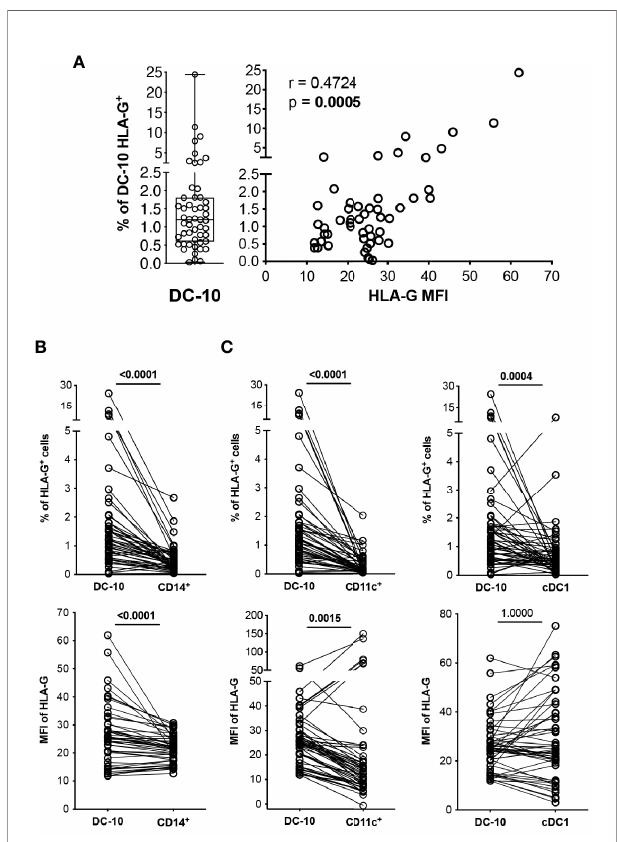
FIGURE 2 | DC-10 contain a high proportion of HLA-G-expressing cells. DC-10 (CD11c + CD14 + CD16 + CD141 + CD163 + ), CD14 + , CD11c + , and cDC1 (CD11c + CD14 − CD141 + ) cells were identi fi ed, and expression levels of HLA-G were evaluated by multiparametric fl ow cytometry in the peripheral blood of 51 healthy donors at different age. (A) Percentages of HLA-G-expressing DC-10. Each dot represents a single donor, line indicates median, and whiskers are minimum and maximum levels (left panel). Scatterplot and Spearman ’ s correlation analyses between the percentage of DC-10 expressing HLA-G and HLA-G mean fl uorescence intensity (MFI) are shown. MFI was evaluated on the whole gated populations. Each data point represents a donor. Data distribution, Spearman ’ s rank correlation coef fi cient (r), and p-value are shown (right panel). (B) Percentages of HLA-G-expressing cells (top panel) and HLA-G MFI (bottom panel) on DC-10 and CD14 + cells. (C) Percentages of HLA-G- expressing cells (top panels) and HLA-G MFI (bottom panels) on DC-10, CD11c + , and cDC1 cells. For (B, C) , each dot represents a single donor; lines connect the data of the same donor. Numbers indicate p-values of paired Wilcoxon ’ s test after Bonferroni ’ s correction. The correction was performed for all comparisons in (B, C) , separately for the type of data (either the percentage of HLA-G-expressing cells or the HLA-G MFI). Statistically signi fi cant p-values are indicated in